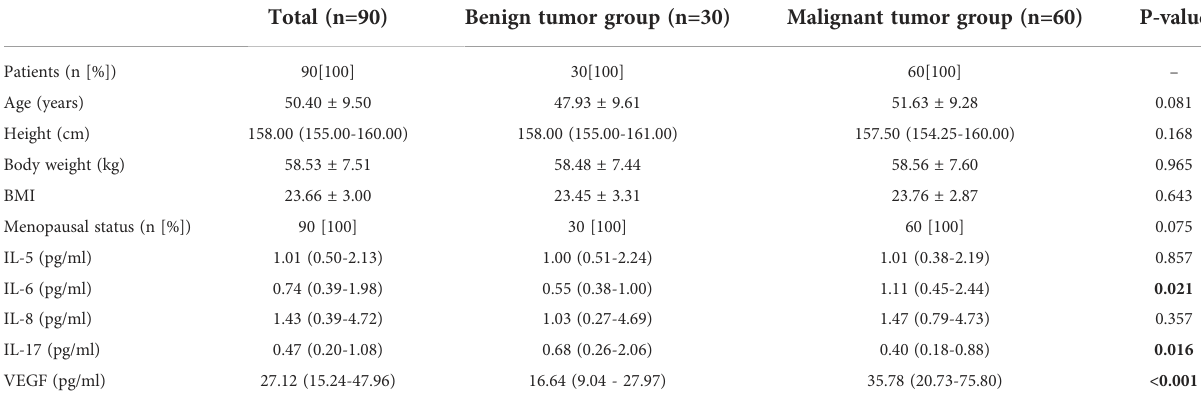
TABLE 1 baseline information table and univariate